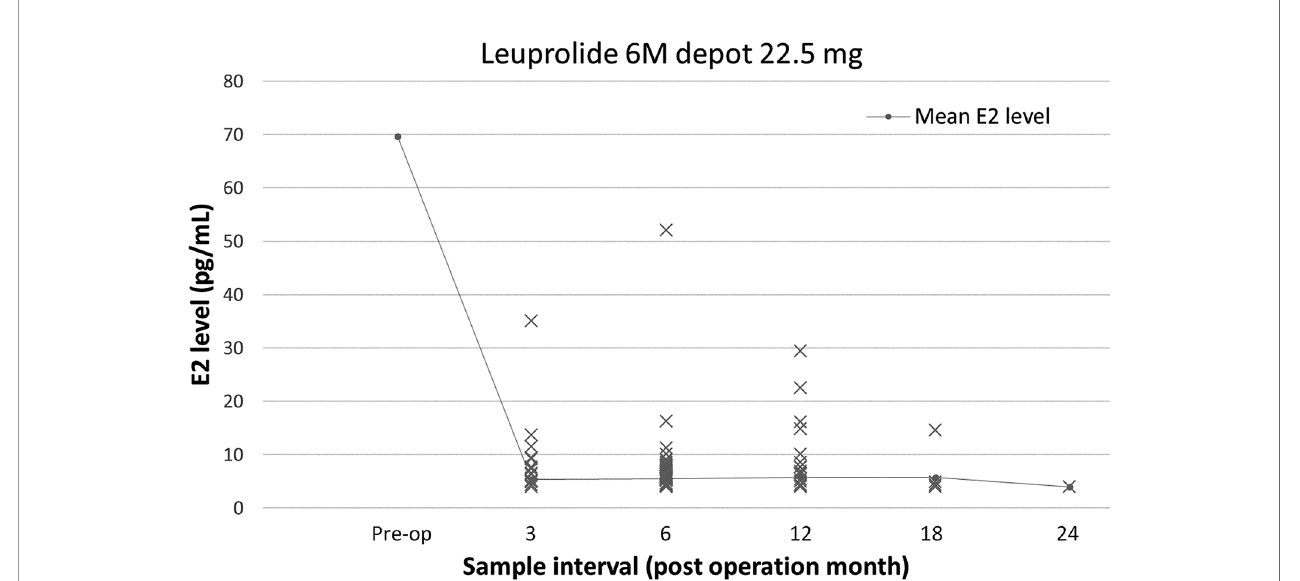
FIGURE 2 | Changes in serum estradiol (E2) levels before and after administration of a luteinizing hormone-releasing hormone analog (LHRHa,